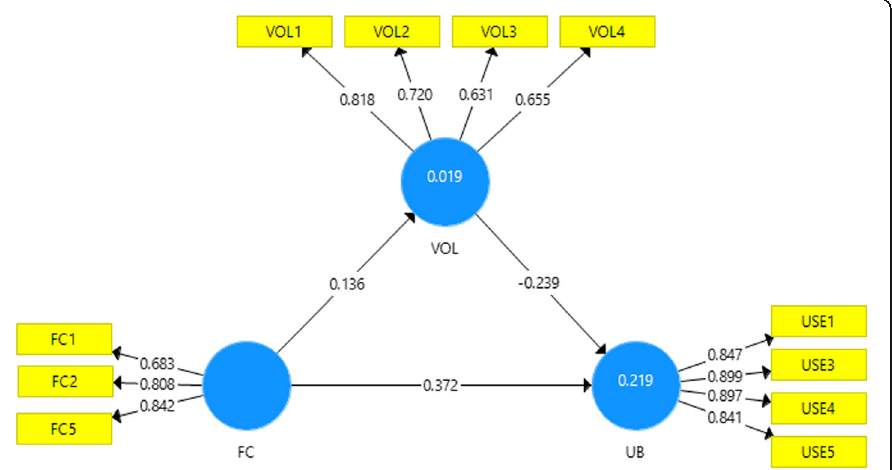
Fig. 2 Algorithm for confirmatory factor